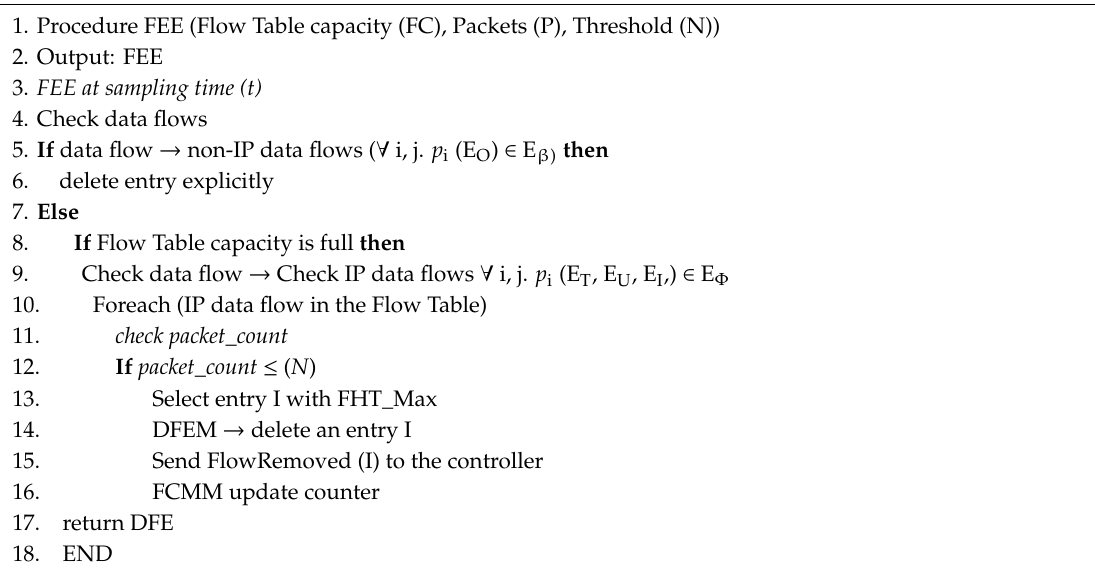
Algorithm 2 . Data Flow Eviction